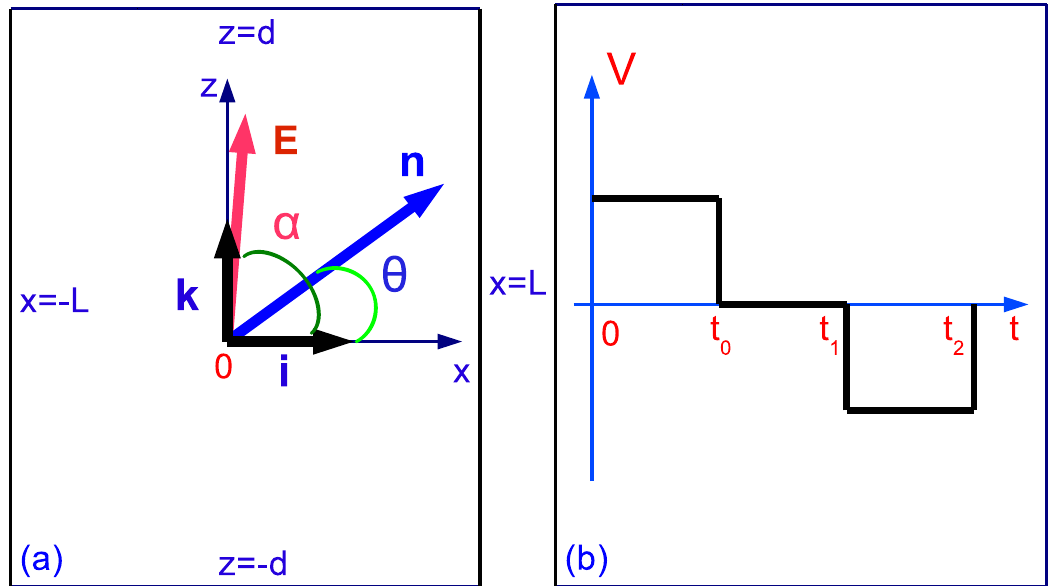
Figure 1. ( a ) The coordinate system used for analyzing the time-resolved NMR experiments and theoretical analysis. The x-axis is taken as being parallel to the magnetic field B and both electrodes. The electric field E and director ˆ n make the angles α and θ , respectively, with the magnetic field B . ( b ) Three regimes of a voltage